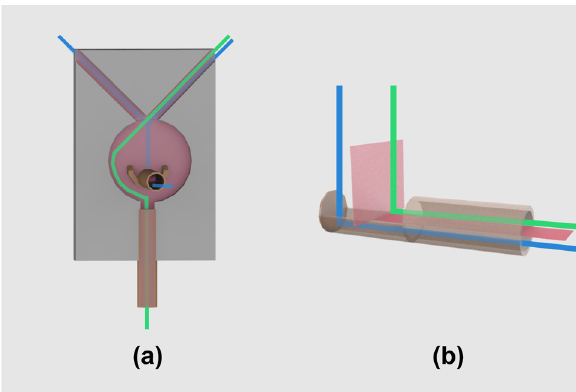
Figure 3: A visualization of how slicing would occur on an AND